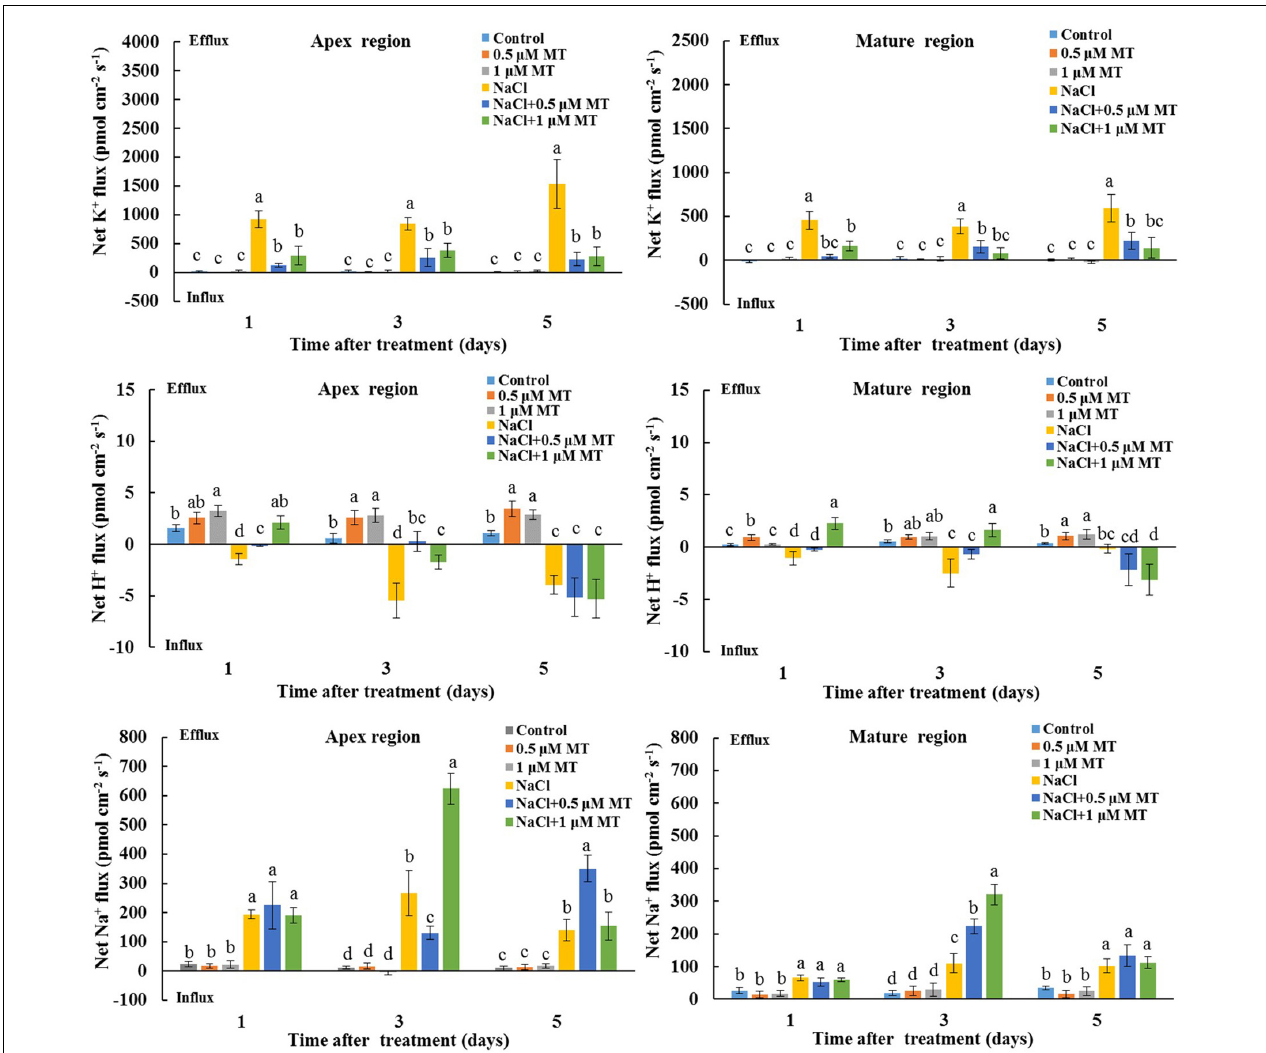
FIGURE 3 | Effects of MT on steady-state fluxes of K + , H + , and Na + in root different regions of NaCl-stressed or non-stressed Xu 32. Xu 32 seedlings were pretreated with 0.5 µ M (root) + 100 µ M (leaf) MT or 1.0 µ M (root) +100 µ M (leaf) MT for 3 days and then subjected to the 150 mM NaCl stress. The steady-state fluxes at the root apex (500–3000 µ m from the tip) and mature region (10–15 mm from the tip) were measured after 1, 3, and 5 days of NaCl treatment. Each column is the mean of a minimum of 10 roots collected from five individual seedlings, and bars represent the standard errors of the mean. Columns labeled with different letters indicate significant difference at P <